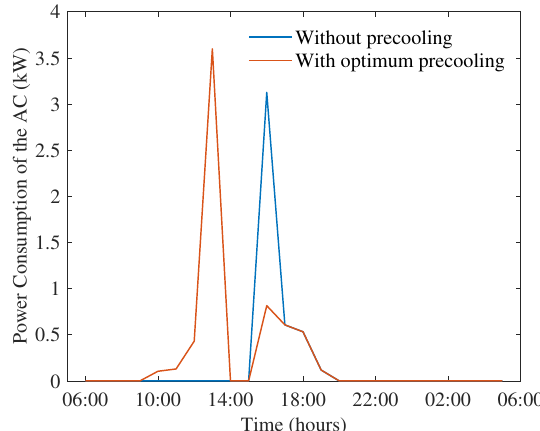
Figure 6. Power consumption of the AC with and without optimum pre-cooling on 18 January